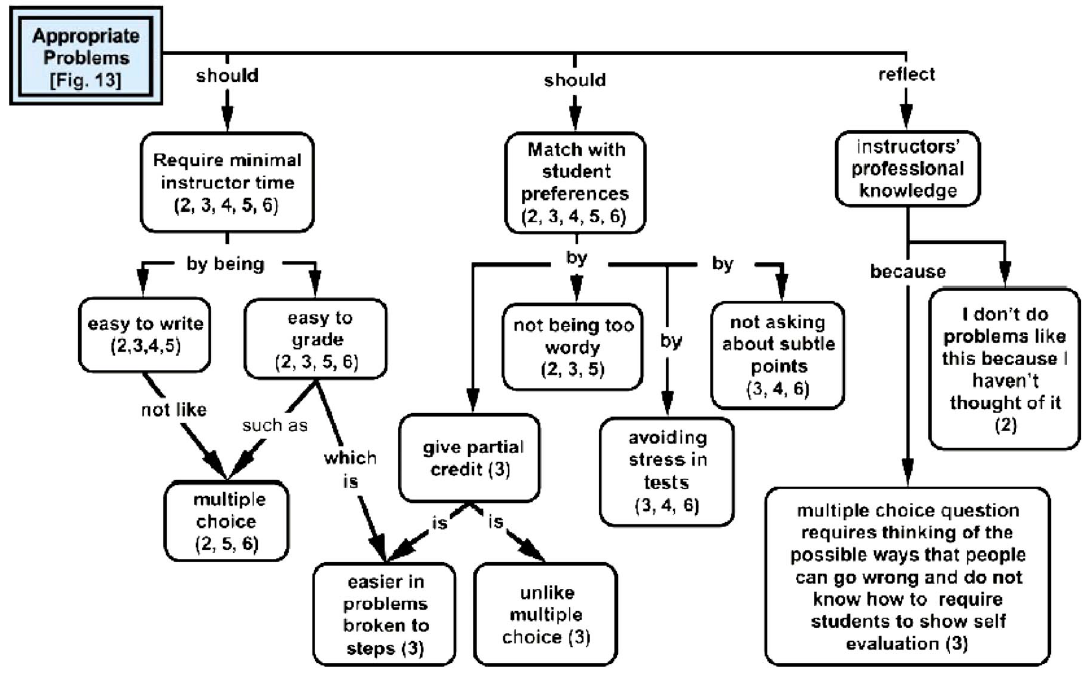
FIG. 13. (cid:1) Color (cid:2) Constraints part of composite map “Appropriate Problems” concerned with faculty beliefs about the appropriate structure of problems in their introductory physics course. Numbers in the parentheses denote the instructor whose statements directly justify that ample Solutions” map (cid:1) completing the partial map of Fig. 11 (cid:2) . Figure 15 shows the constraints part of the “Individual- ized Responses” map (cid:1) completing the partial map of Fig. 12 (cid:2) .